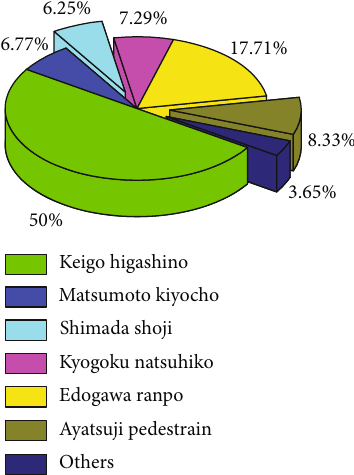
Figure 1: Distribution of Japanese literary writers that readers have heard of and